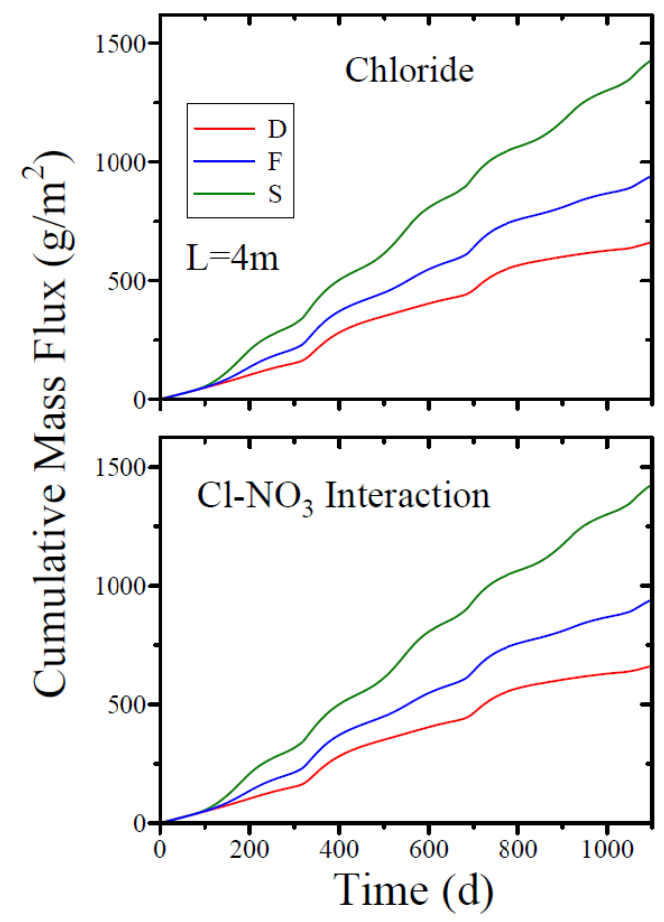
Figure 9. Cumulative mass fluxes of chloride crossing a horizontal CP located at soil depth, L = 4 m, for the different scenarios examined. Top panel — the effect of the chloride on N uptake and nitrification was disregarded.